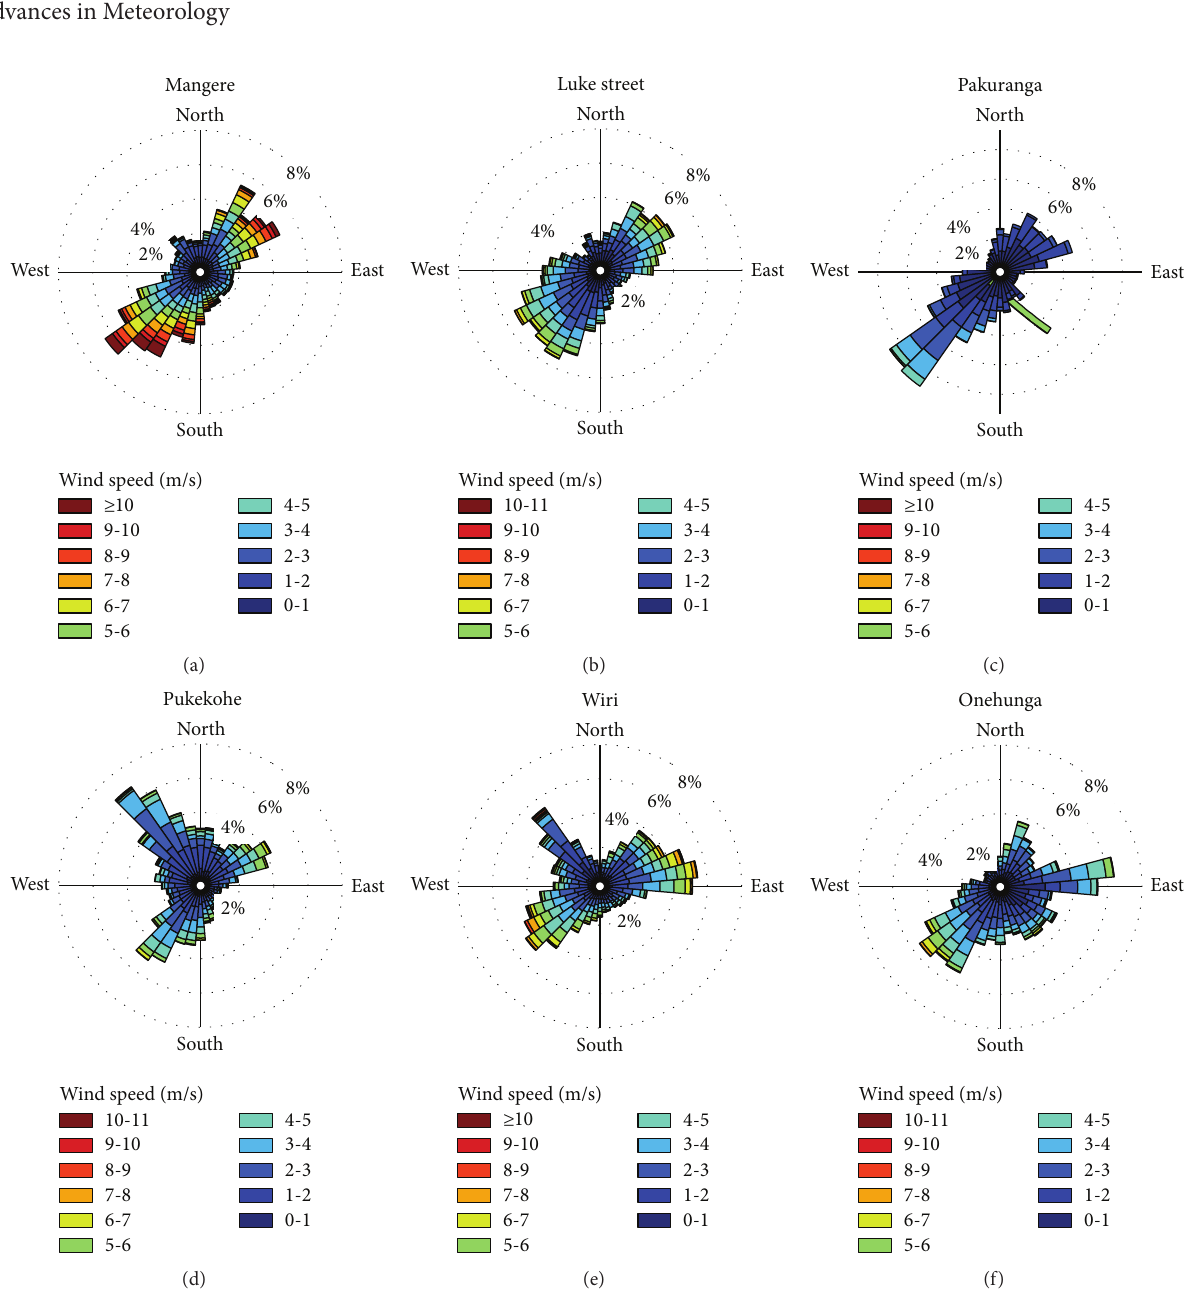
on the plots is the 95% confidence interval of the means calculated through bootstrap resampling. The distributions of CO and NO 𝑋 are consistent with peaks during the morning and evening rush hours with concentrations persisting into the early night. An inverse relationship between pollutant concentrations and wind speed is also well depicted from Figure